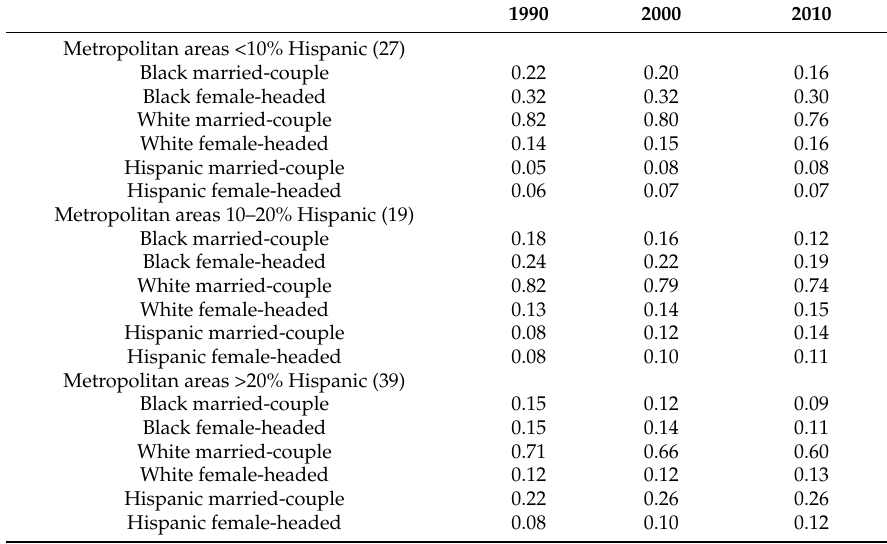
Table 3. Average isolation for 85 metropolitan areas with at least 500 households in each category by percent Hispanic population, using Census 1990–2010 from the